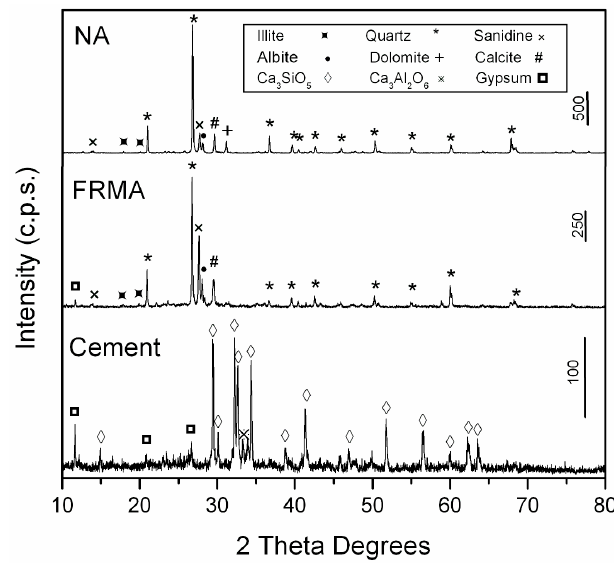
Figure 2. PXRD patterns of NA and FRMA aggregates and cement.